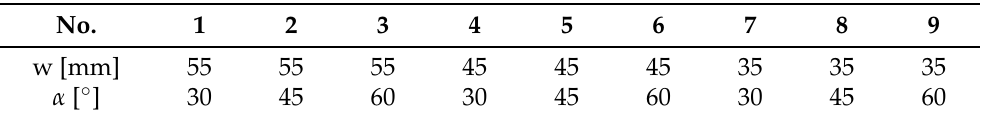
Figure 5. Example geometric model of a trapezoidal heat sink. Table 1. Cutting plane parameters by which modified geometric models of the heat sink were ob-